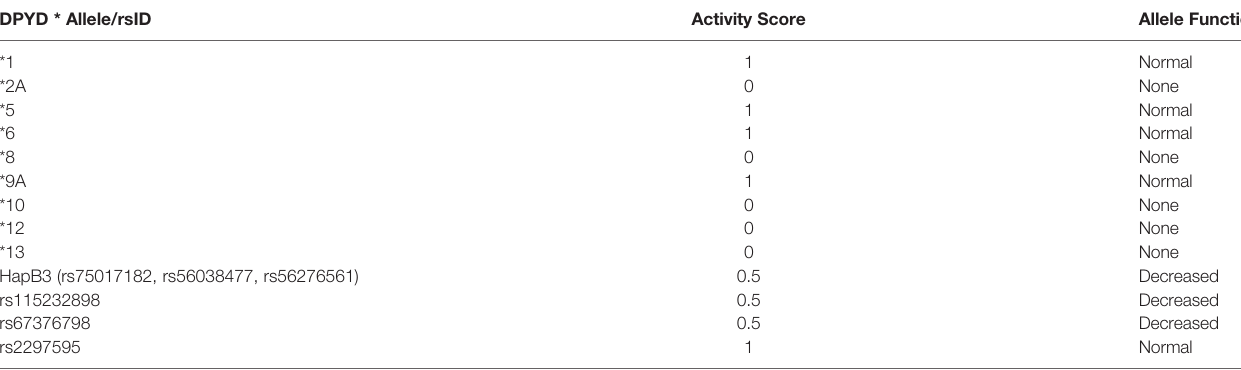
TABLE 2 | DPYD allele function and activity score.